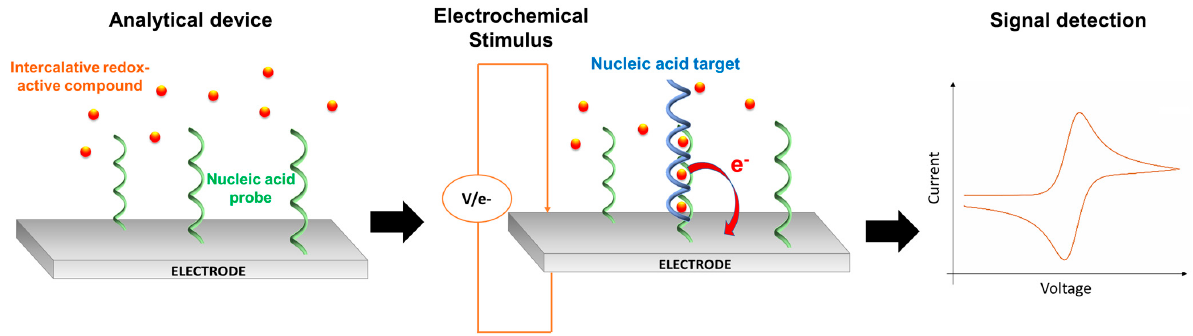
Figure 3. Generic scheme of nucleic acid analysis through intercalative redox-active compounds: detail of the electrochem- ical stimulus generation, by target–probe NA interaction and redox compound intercalation inside the dsNA, and the electrochemical signal detection.